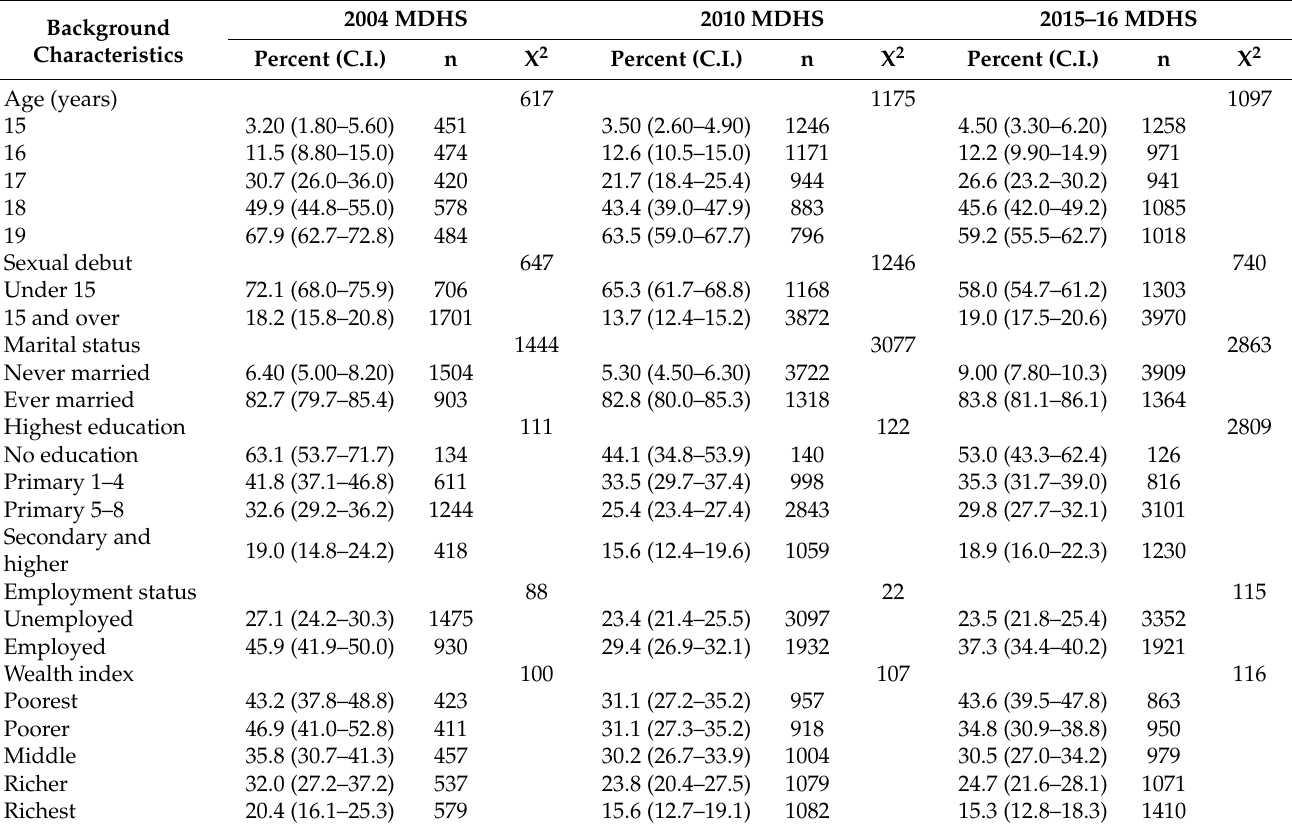
Table 3. Trends in prevalence of teenage childbearing from 2004 to